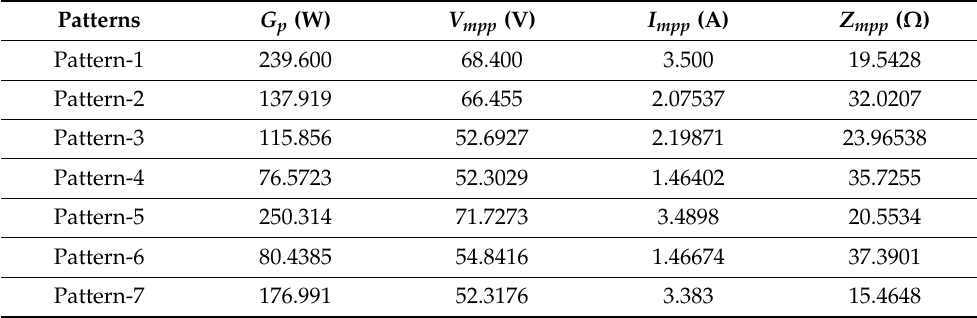
Table 5. Global peak power ( G p ) for different